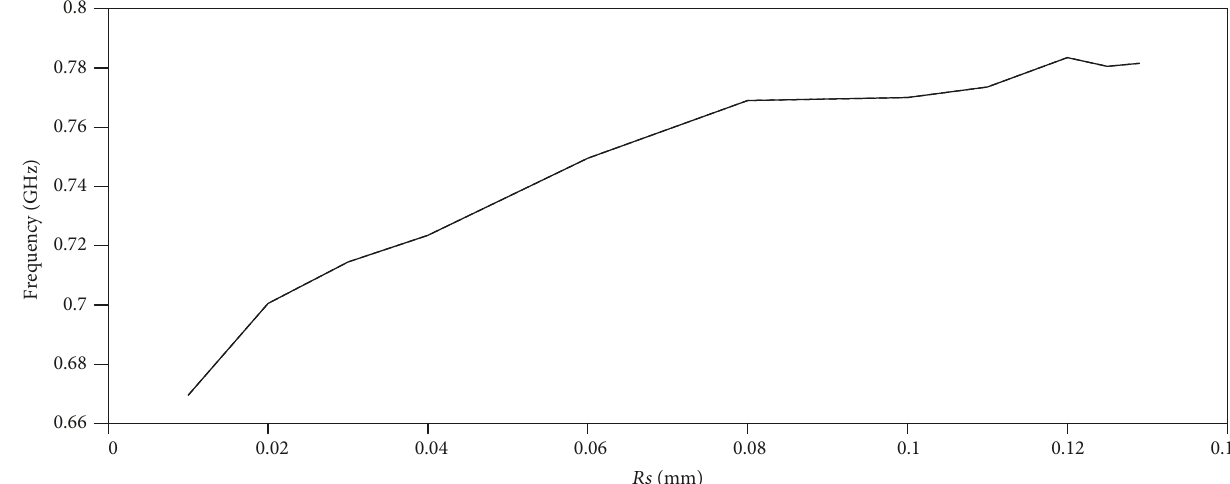
k = 2 . s for the Koch fractal antenna of level